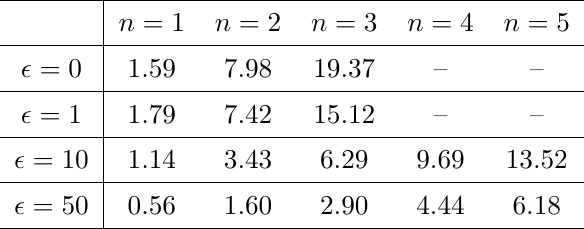
Table 2 . Critical masses for the (cid:12)rst (cid:12)ve oscillating modes for the full Skyrme model with the ( p =1) . No value denotes that the critical point occurs above m = 20. usual Skyrme potential U